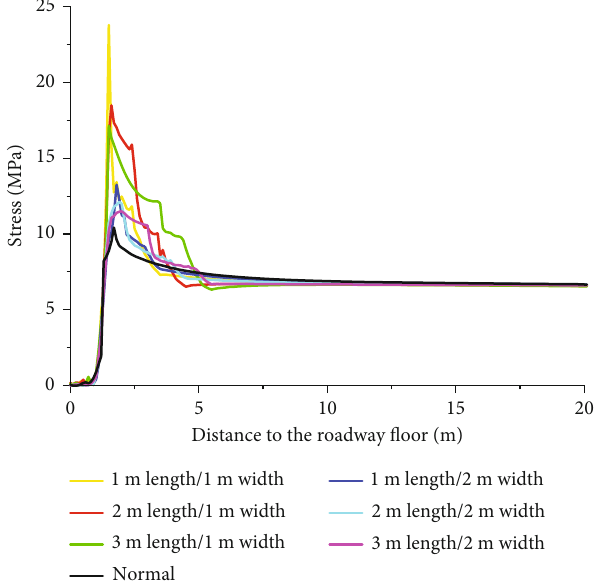
Figure 5: Vertical stresses below the fl oor of the heading face for each